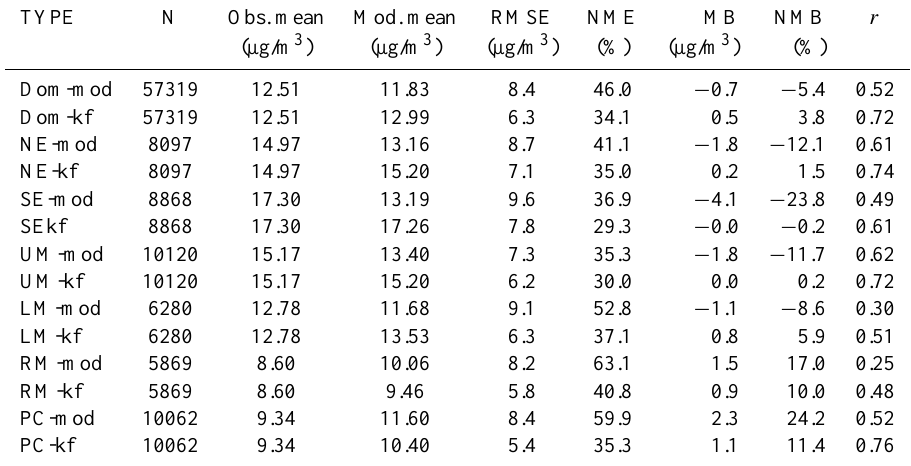
Table 2. Regional summary of discrete statistics for raw model and KF bias-adjusted daily mean PM 2 . 5 forecasts during 2007 warm